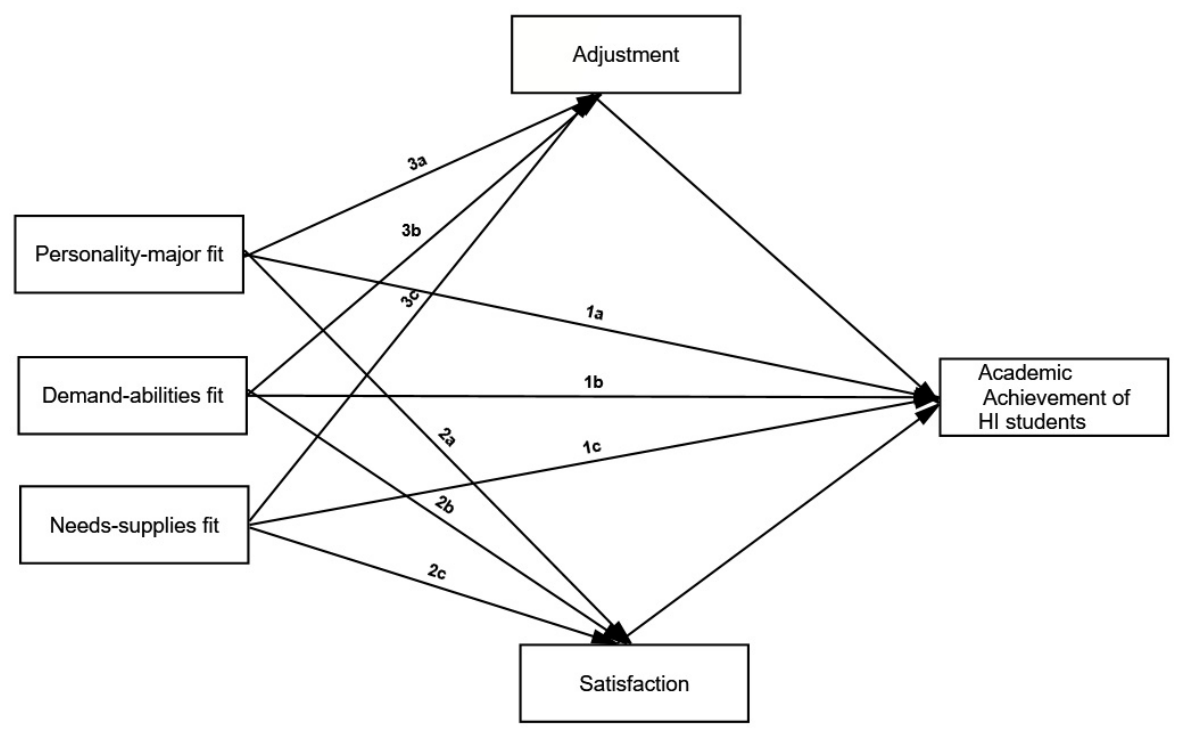
Figure 1. The proposed research model.